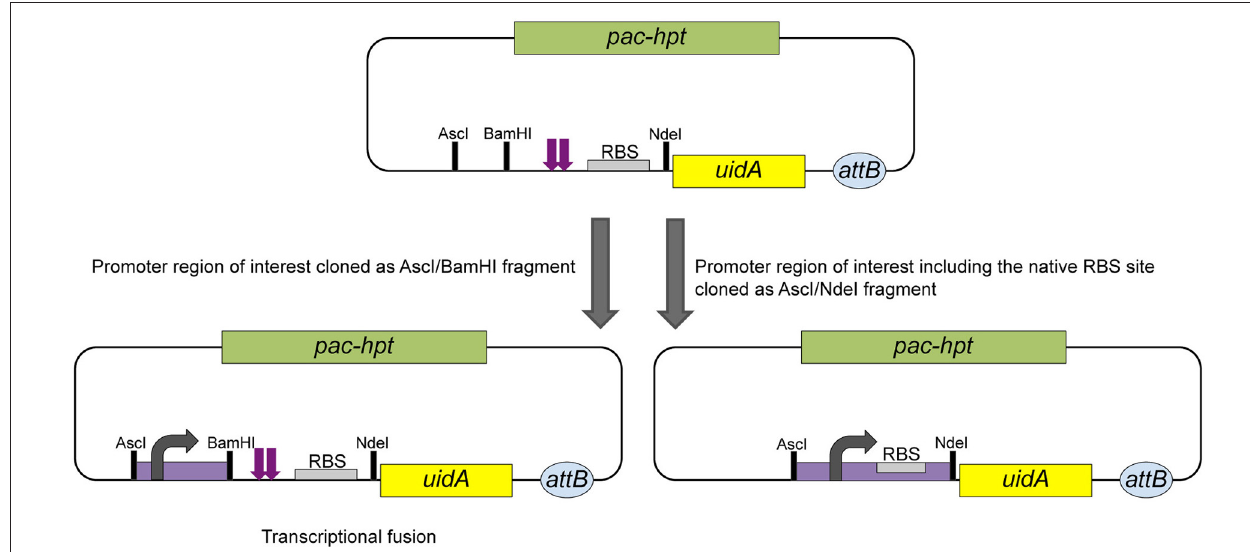
FIGURE 4 | Schematic of the construction of transcriptional and translational reporter gene fusions using pAB79. Transcriptional fusions can be achieved by cloning the promoter region of interest as an AscI/BamHI fragment into pAB79. In this construct transcription is initiated from the cloned promoter (bend arrow). During translation no read through can occur from the cloned fragment into the uidA gene ( β -glucuronidase) due